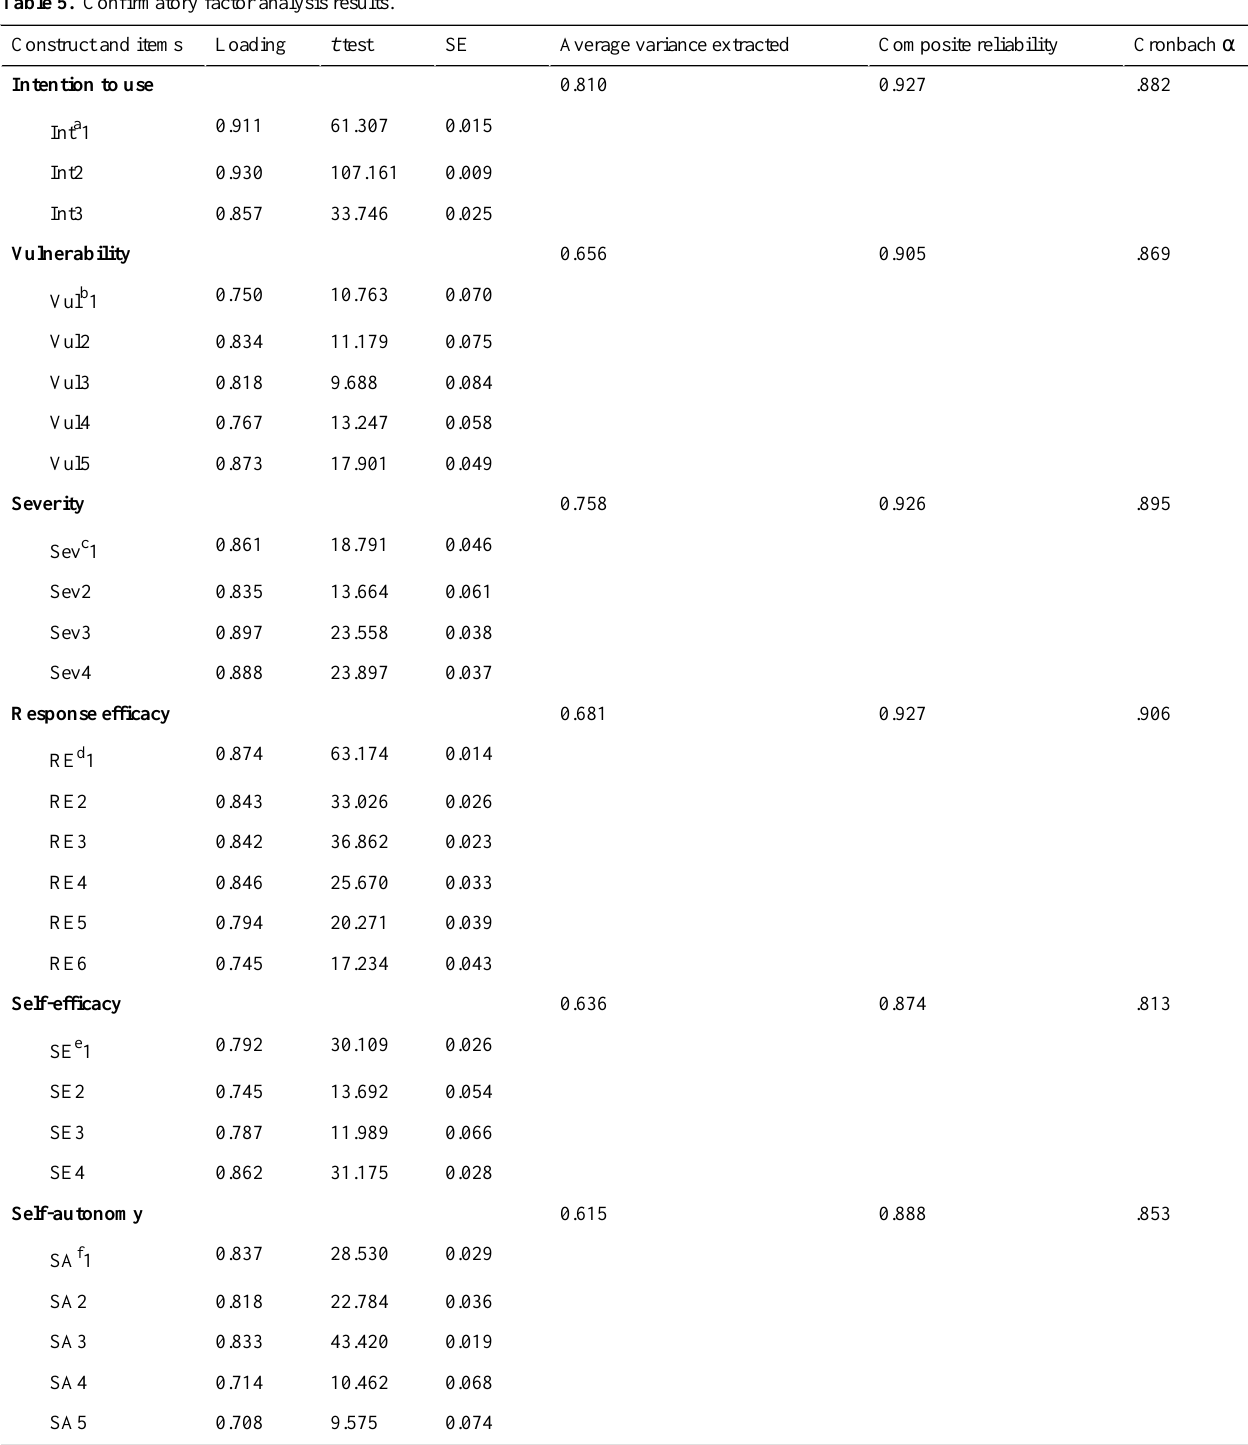
Table 5. Confirmatory factor analysis